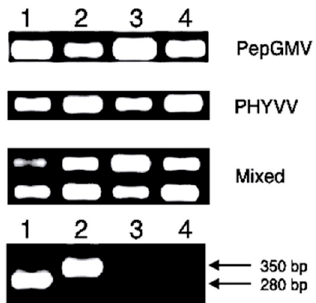
Figure 6. Detection by PCR of common region of PHYVV and PepGMV at 90 dpi in lower and upper leaves in C. chinense BG-3821 either in single or mixed infections. Lanes 1 and 3 , lower and upper leaves in silenced plants, respectively; Lanes 2 and 4 , lower and upper leaves in no-silenced plants. In the bottom section, lane 1, positive control of wt PepGMV component A (280 bp); lane 2, PHYVV Component A (350 bp); Lane 3, negative control, of DNA from a pBS mock-inoculated plant; lane 4, negative control of un-inoculated plant.